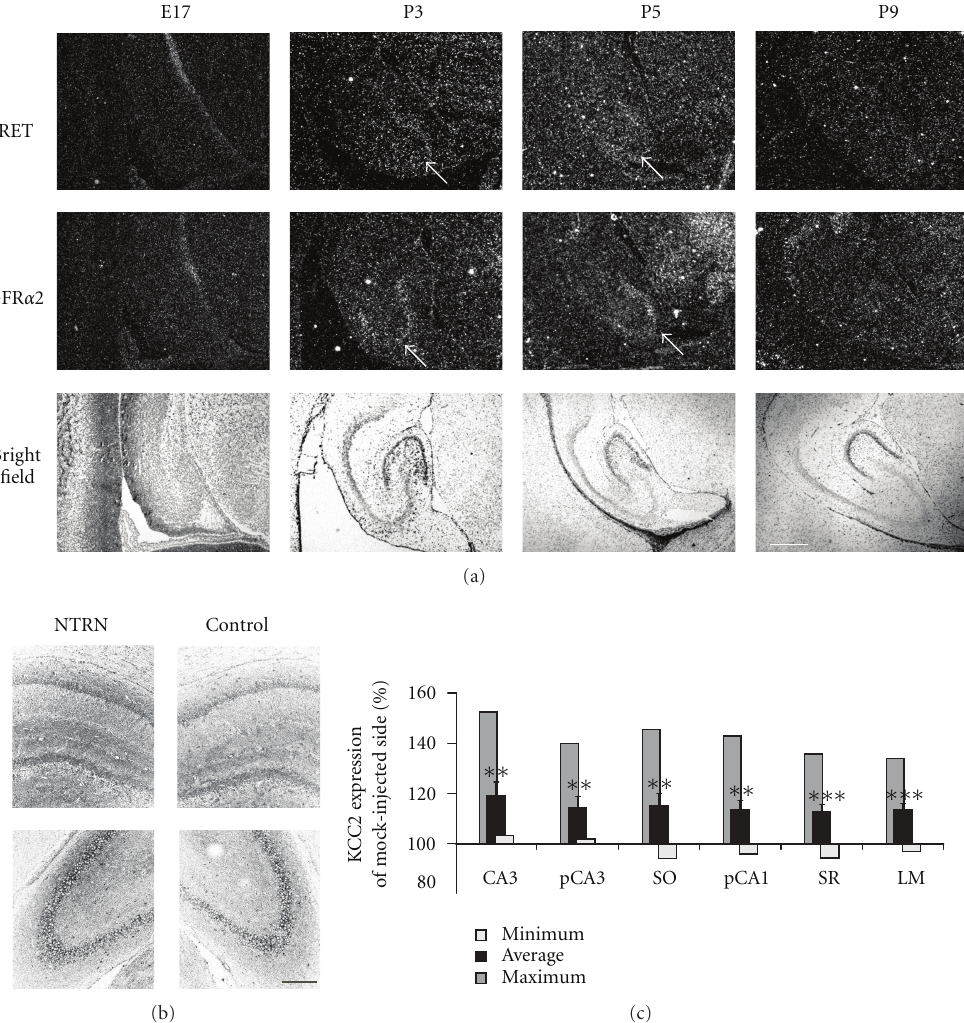
Figure 3: Regulation of KCC2 expression by Neurturin in vivo . (a) RET and GFR α 2 mRNA expression was detected by in situ hybridization. Note the accumulation of RET and GFR α 2 at P3 and P5 in the CA3 region of the hippocampus (marked with arrowheads). Scale bar = 500 μ m. (b) Representative immunofluorescent stainings of KCC2 expression in Neurturin-treated and control hippocampi 3 days after in- jection. Neurturin (1 μ g) was used for injection in right-side hippocampus of P5 rat while contralateral hippocampus was injected with saline solution. (c) Summary results of KCC2 immunostaining intensity for di ff erent layers of CA1 and CA3 in Neurturin-injected hemisphere ( n